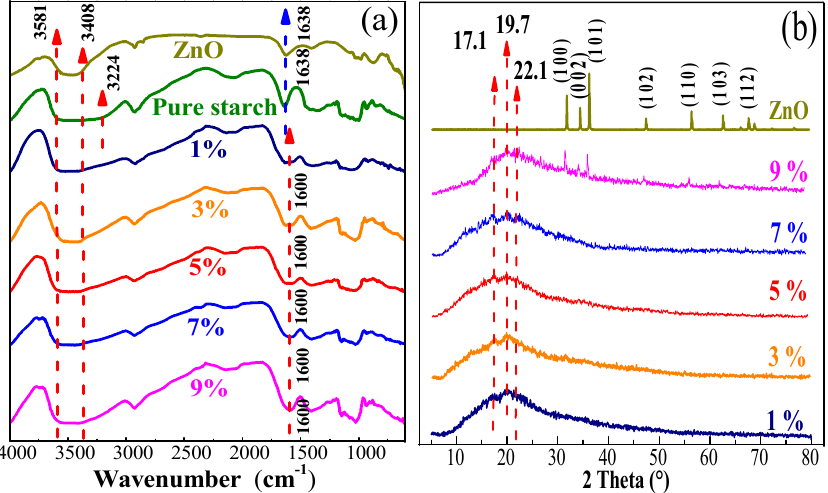
Figure 2. The FTIR spectra ( a ) and XRD patterns ( b ) of pure starch films and composite films with various ZnO NPs dosages.